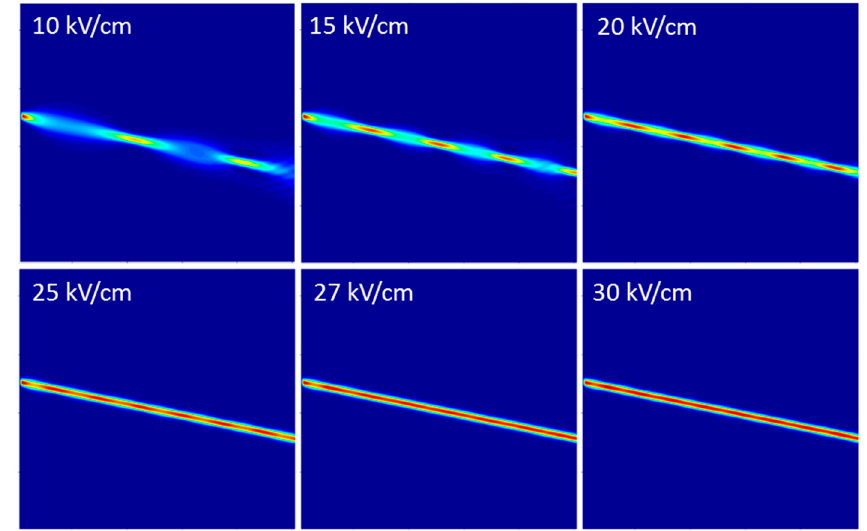
Figure 2. Linear propagation of the signal beam within the nonlinear waveguides as a function of the applied bias. Only at about 27 kV/cm is the signal propagation clean and without pulsing, which we call soliton waveguiding or propagation inside a waveguiding soliton.